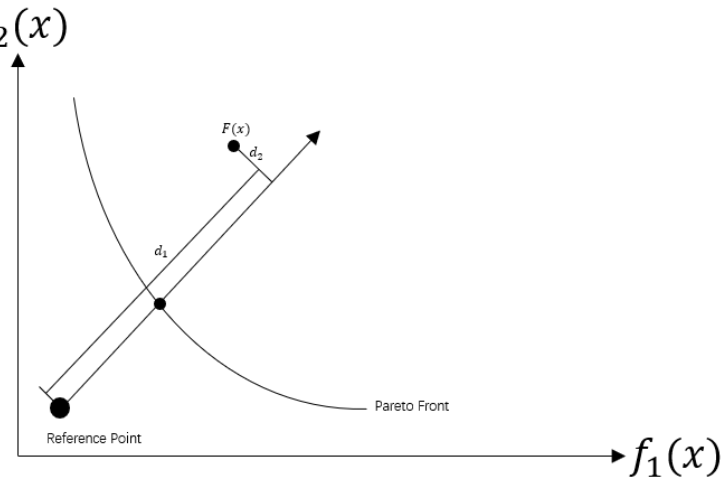
Figure 2. Illustration of